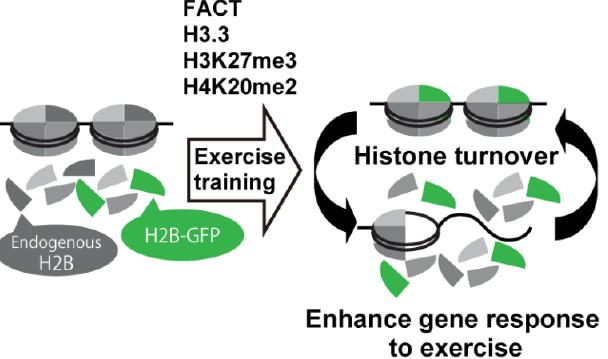
Figure 4. Overview of exercise-induced histone turnover. Tetracycline-inducible H2B-GFP expression model demonstrated the histone turnover in skeletal muscle fibers [30]. Since the histone turnover is referred to as the exchange of histone components with new histones, the incorporation of induced H2B-GFP into nucleosomes indicates the turnover of histone H2B. Upregulation of myonuclear facilitates chromatin transcription (FACT), and histone remodelers, such as H3.3, H3K27me3, and H4K20me2, were associated with the activation of histone turnover, which drastically enhanced the gene response to a single bout of exercise.